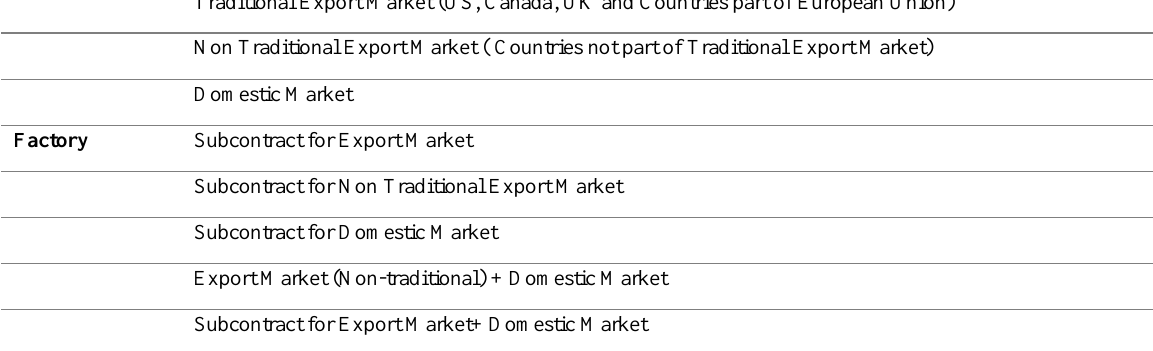
Table 1: Factory Market